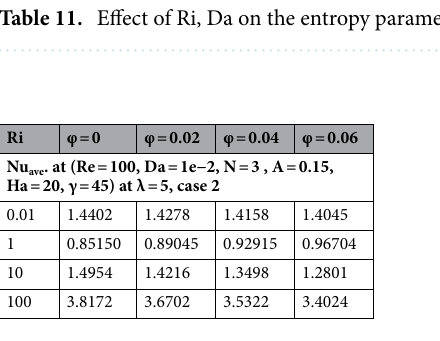
Table 12. Effect of Ri and ϕ on the average Nu for Case